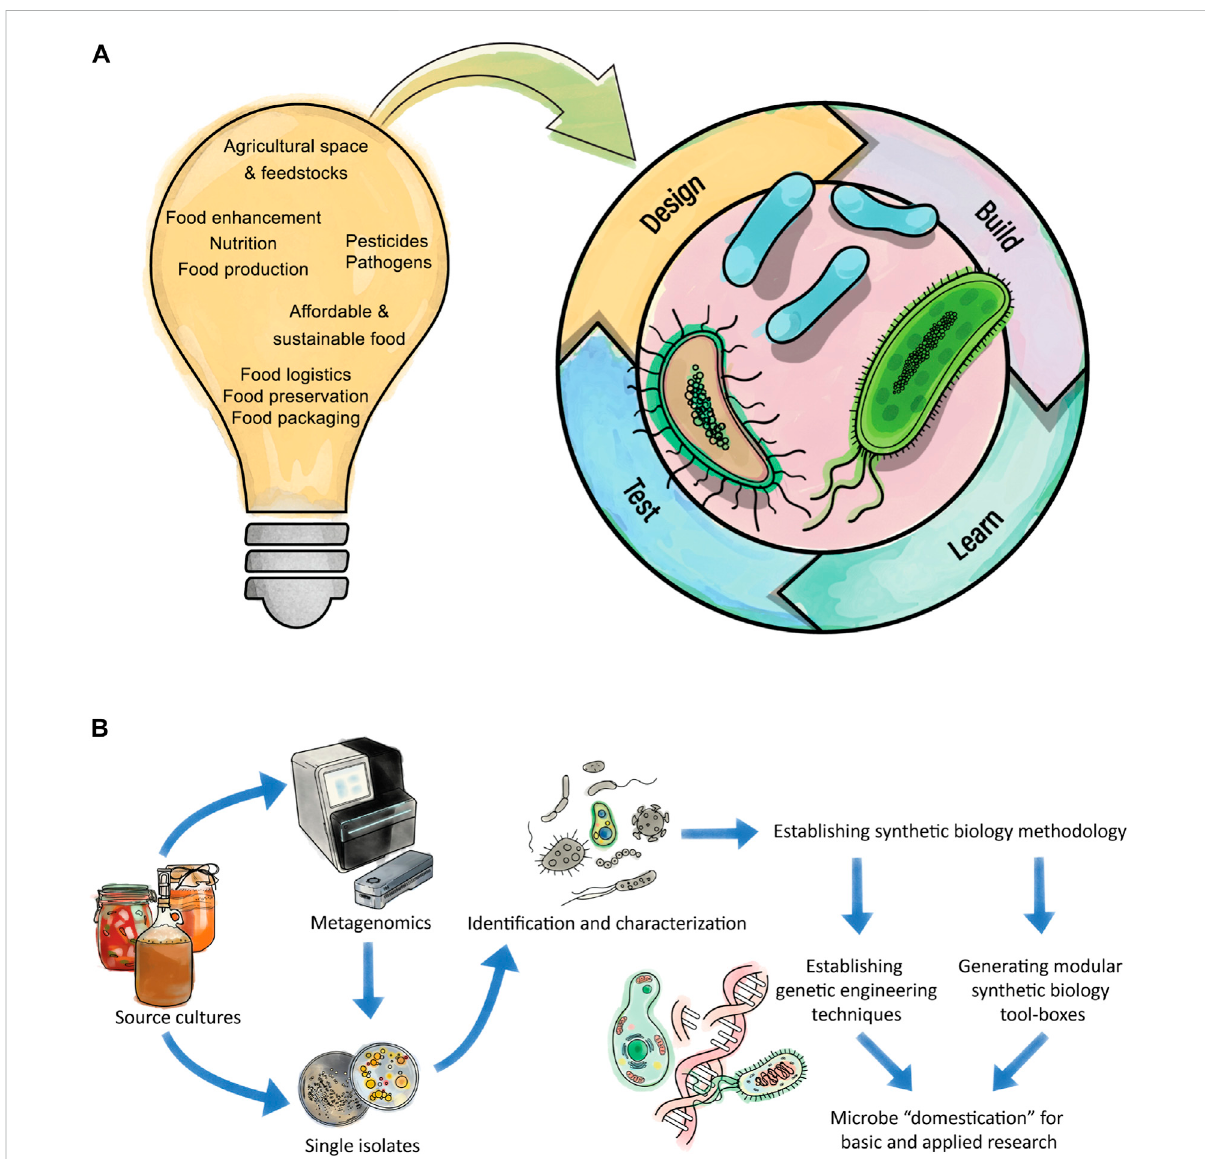
FIGURE 1 Challengesoffuturefoodswhichgiverisetoopportunitiesforsyntheticbiology. (A) Syntheticbiologytriestoimplementengineeringprinciples into life. The lightbulb highlights some of the challenges for future foods. These challenges may be inspirational for experimental designs for synthetic biology methodology with the potential to improve a process or overcome related problems. Microbes can be altered through the “ Design-Build-Test-Learn ” cycle for a greater aim and particular microbes from traditional fermentation processes have the potential to address future food challenges. (B) Work fl ow showing a pipeline to domesticate microbes, for example from traditional fermentations processes. The initial source can be analyzed by traditional isolation of individual microbes or by metagenomics approaches to initially get an overview of the community before individuals are isolated. The isolated microbes need to be identi fi ed and characterized. Once the organism is known, one can start to make the organism accessible for synthetic biology approaches. Therefore, initial genetic engineering methods need to be established (i.e., transformation procedures), followed by advances in engineering tools (i.e., CRISPR/Cas-based methods) and the generation of modular tool-boxes for quick and reliable engineering of the organism. The established tools allow microbe domestication, for example by removal or addition of genes, for easier handling. Subsequently the domesticated microbe can be used for intensive engineering towards a desired goal for example the assimilation of a sustainable